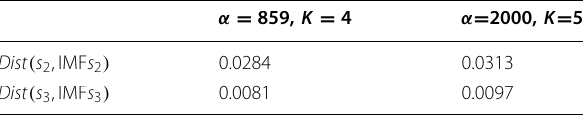
Table 1 The cosine distance of simulated shock signal and the decomposed signal